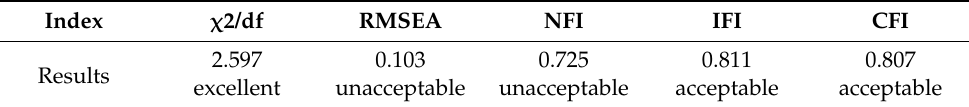
Table 6. Initial SEM fit